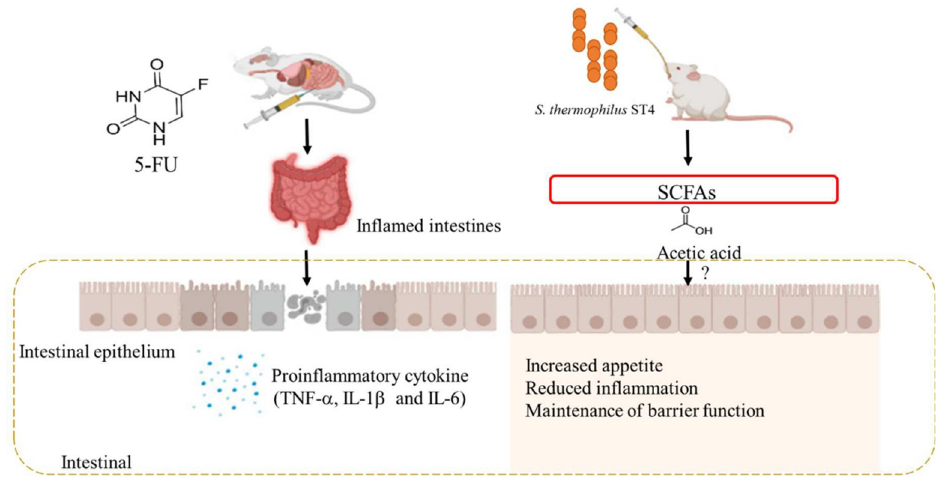
Fig 5. A schematic model for S . thermophilus ST4 attenuating 5-FU-induced intestinal mucositis. Elevation of SCFAs, for example acetic acid, in intestine enables diminishment of inflammation as well as maintenance of barrier function in intestine and colon, therefore resulting in increased appetite and in reducing diarrhea in the 5-FU-induced intestinal